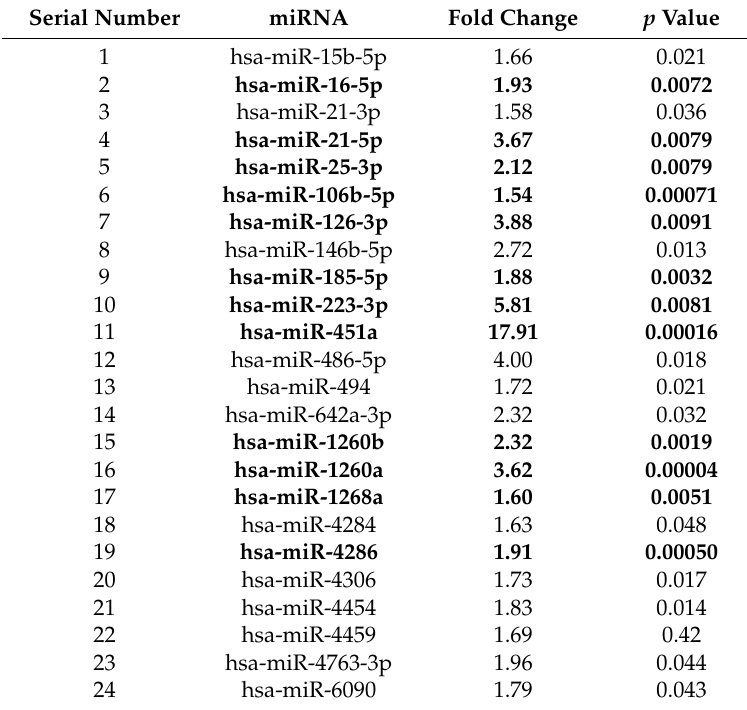
Figure 5. Volcano map demonstrating differences in miRNA expression levels in TAA by microarray. The log-fold change is plotted against the log odds of differential expression. The miRNAs with significant differences in expression levels between the TAA ( n = 5) and control ( n = 3) groups ( p < 0.05) after Benjamini-Hochberg correction are indicated. Table 3. Upregulated TAA miRNAs in Agilent’s Human miRNA microarray Release 19.0 *.